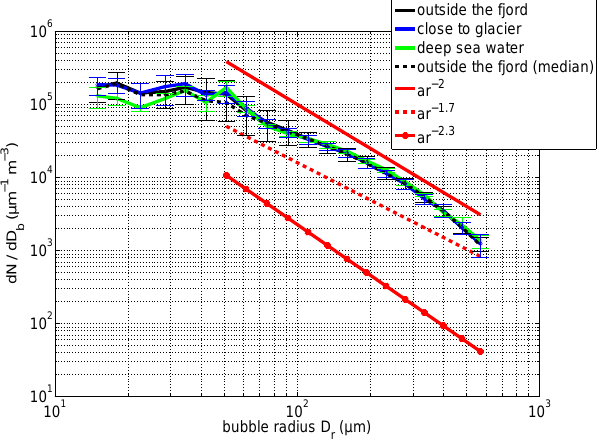
Fig. 3. Solid lines represent arithmetic means with standard devia- tions for bubble population distributions versus bubble diameter for different water sampling locations. The black dashed line shows as an example a median for comparison with the arithmetic mean. Av- erages are based on 28, 9, and 5 bubble spectra measurements from bubbles produced in water with its origin outside the fjord (black line), close to the glacier (blue line) and deep water (green line), re- spectively. Red lines represent power law functions d N/ d r = ar − b with the bubble radius r for b = 2, b = 1 . 7 and b = 2 .